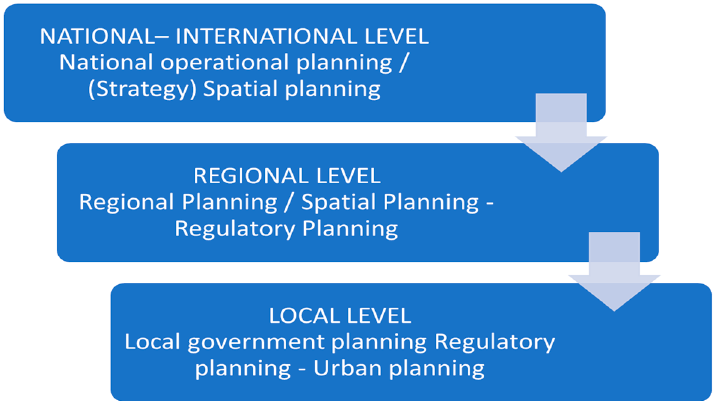
Figure 3. The levels of the Greek spatial policy.